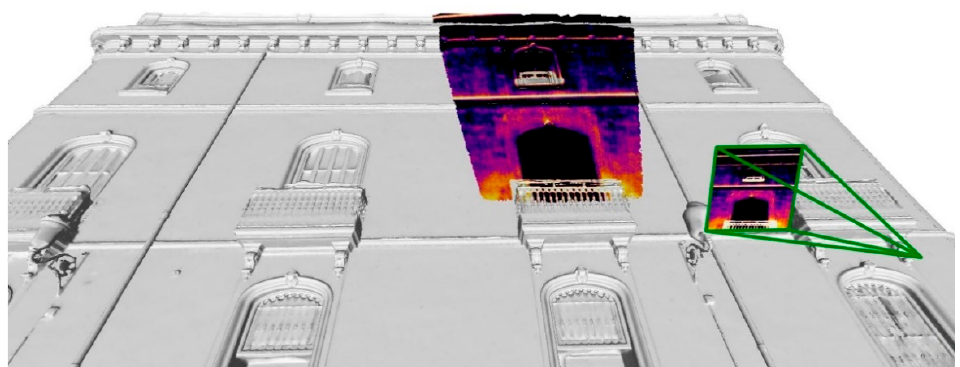
Figure 15. Projection of the TIR image evidencing a thermal discrepancy in the eastern façade, coherent with the presence of the remains of a previous frame of one of the main floor windows.